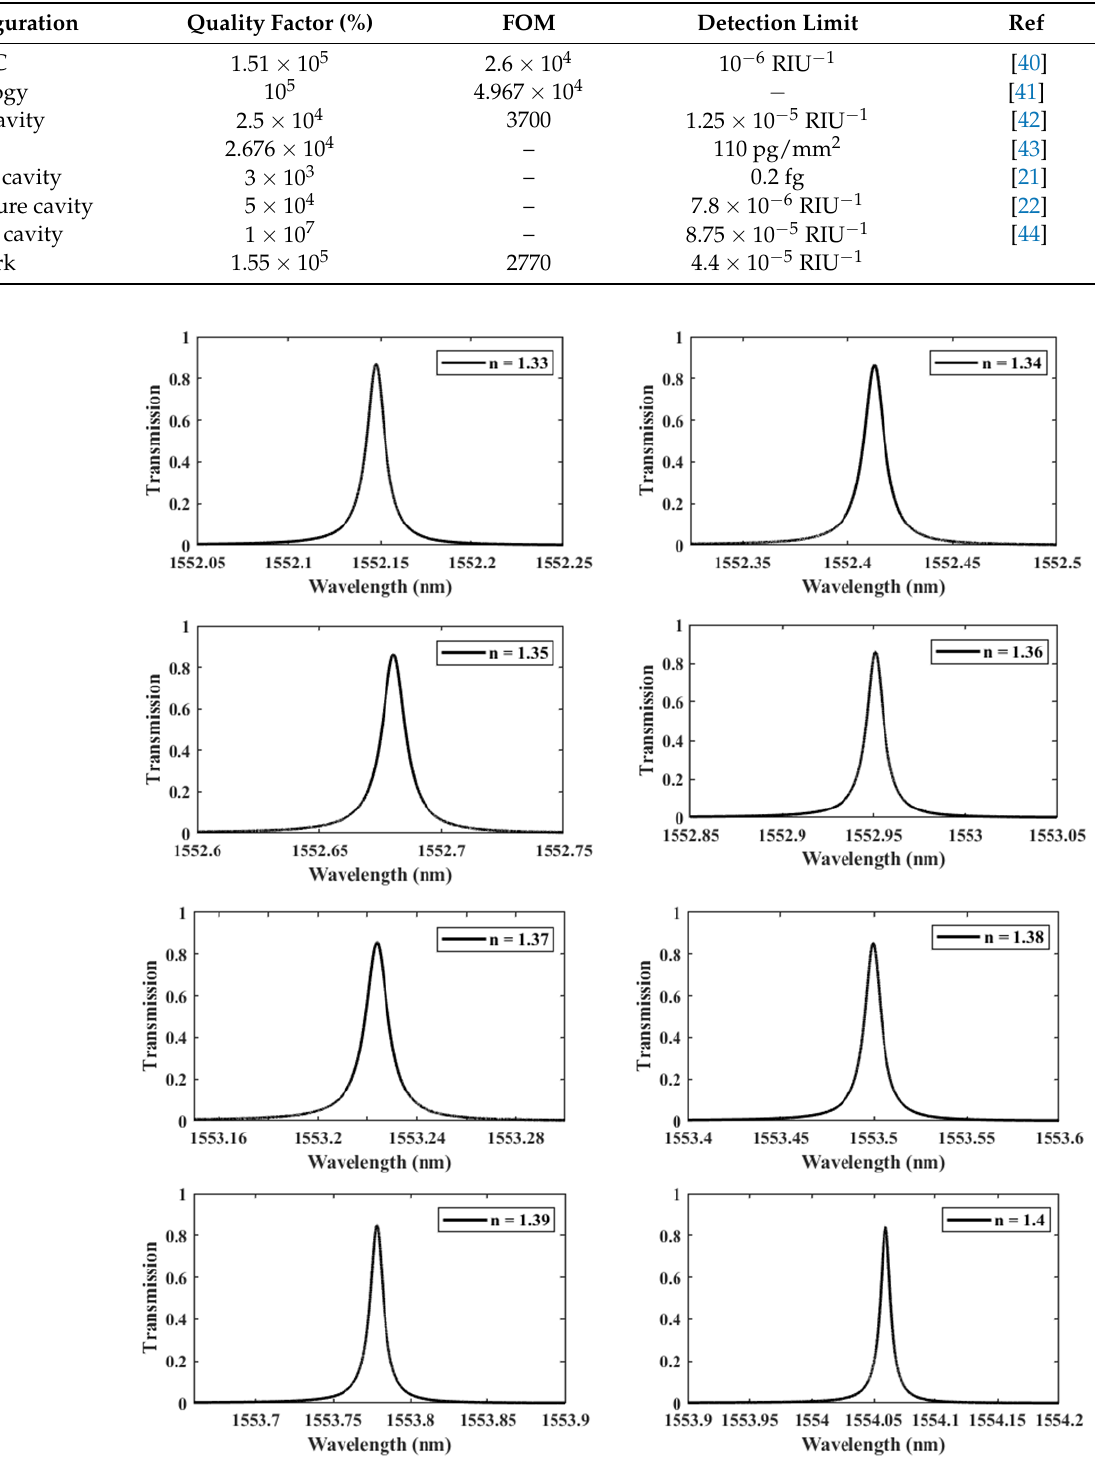
Figure 5. The shifting of the resonance wavelength with respect to the refractive index n of the sample varied from 1.33 to 1.4, demonstrating different phases of DNA